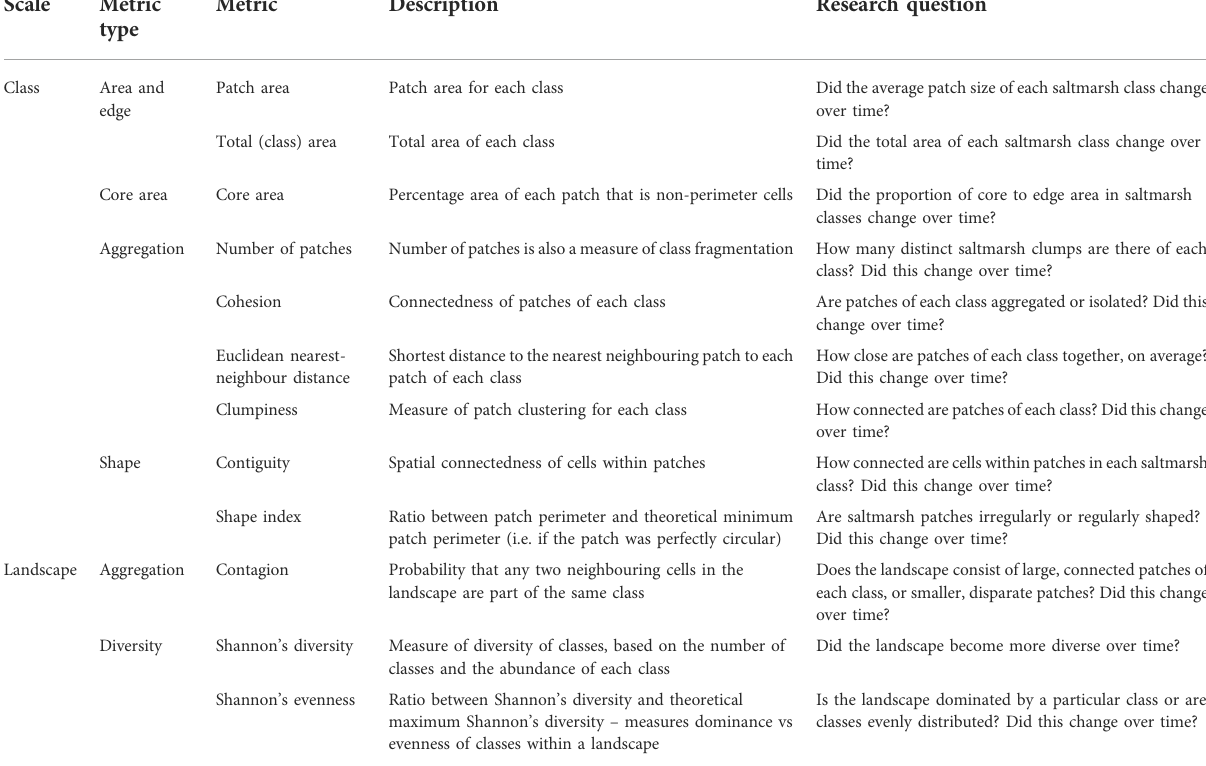
TABLE 3 Class- and landscape-level patch metrics calculated from classi fi ed images, and relevant research